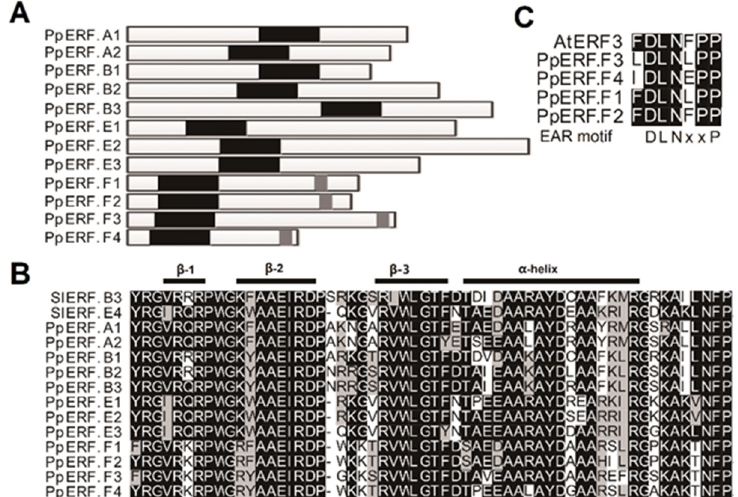
Figure 3. Diagram and alignment of ERF transcription factors (TFs). ( A ) structural diagram of the 12 PpERFs highly expressed in peach mesocarp. Black background boxes represent the AP2 / ERF domain. The grey boxes stand for the EAR-repressing motif. ( B , C ) alignments of the EAR motif and AP2 / ERF domain of the ERFs in peach and other species, respectively.